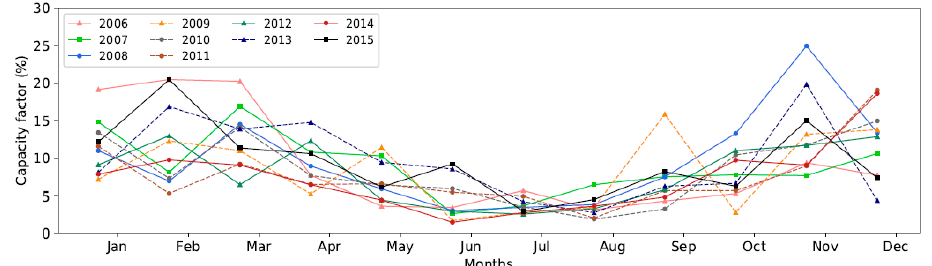
Figure 13. Yearly time series of the monthly variations of predicted capacity factor from a Oyster prototype with a rated power of 90 kW at the western end of the line offshore from the harbour breakwater over the ten-year period from 2006 to 2015.